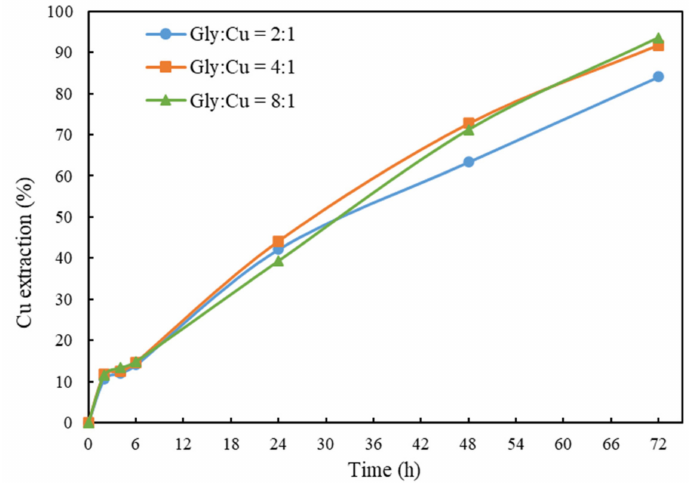
Figure 5. Cu extraction after 72 h of leaching at different Gly:Cu molar ratios. Other conditions: